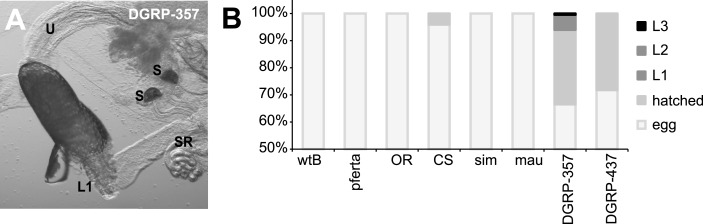
Egg hatching in morinda.(A) D. melanogaster DGRP-357 first-instar larvae (L1) hatching inside the female reproductive system. U: uterus; S: spermatheca; SR: seminal receptacle. Scale bar 20 μm. (B) Proportion of eggs hatched or moulted to larva 1 (L1) larva 2 (L2) or larva 3 (L3), in D. melanogaster wild-type Berlin (wtB), D. melanogaster pferta (pferta), D. melanogaster Oregon-R (OR), D. melanogaster Canton-S (CS), D. melanogaster DGRP-357 (DGRE-357) D. melanogaster DGRP-437 (DGRP-437), D. simulans (14021–0251.004, sim) and D. mauritiana (14021–0241.01, mau).